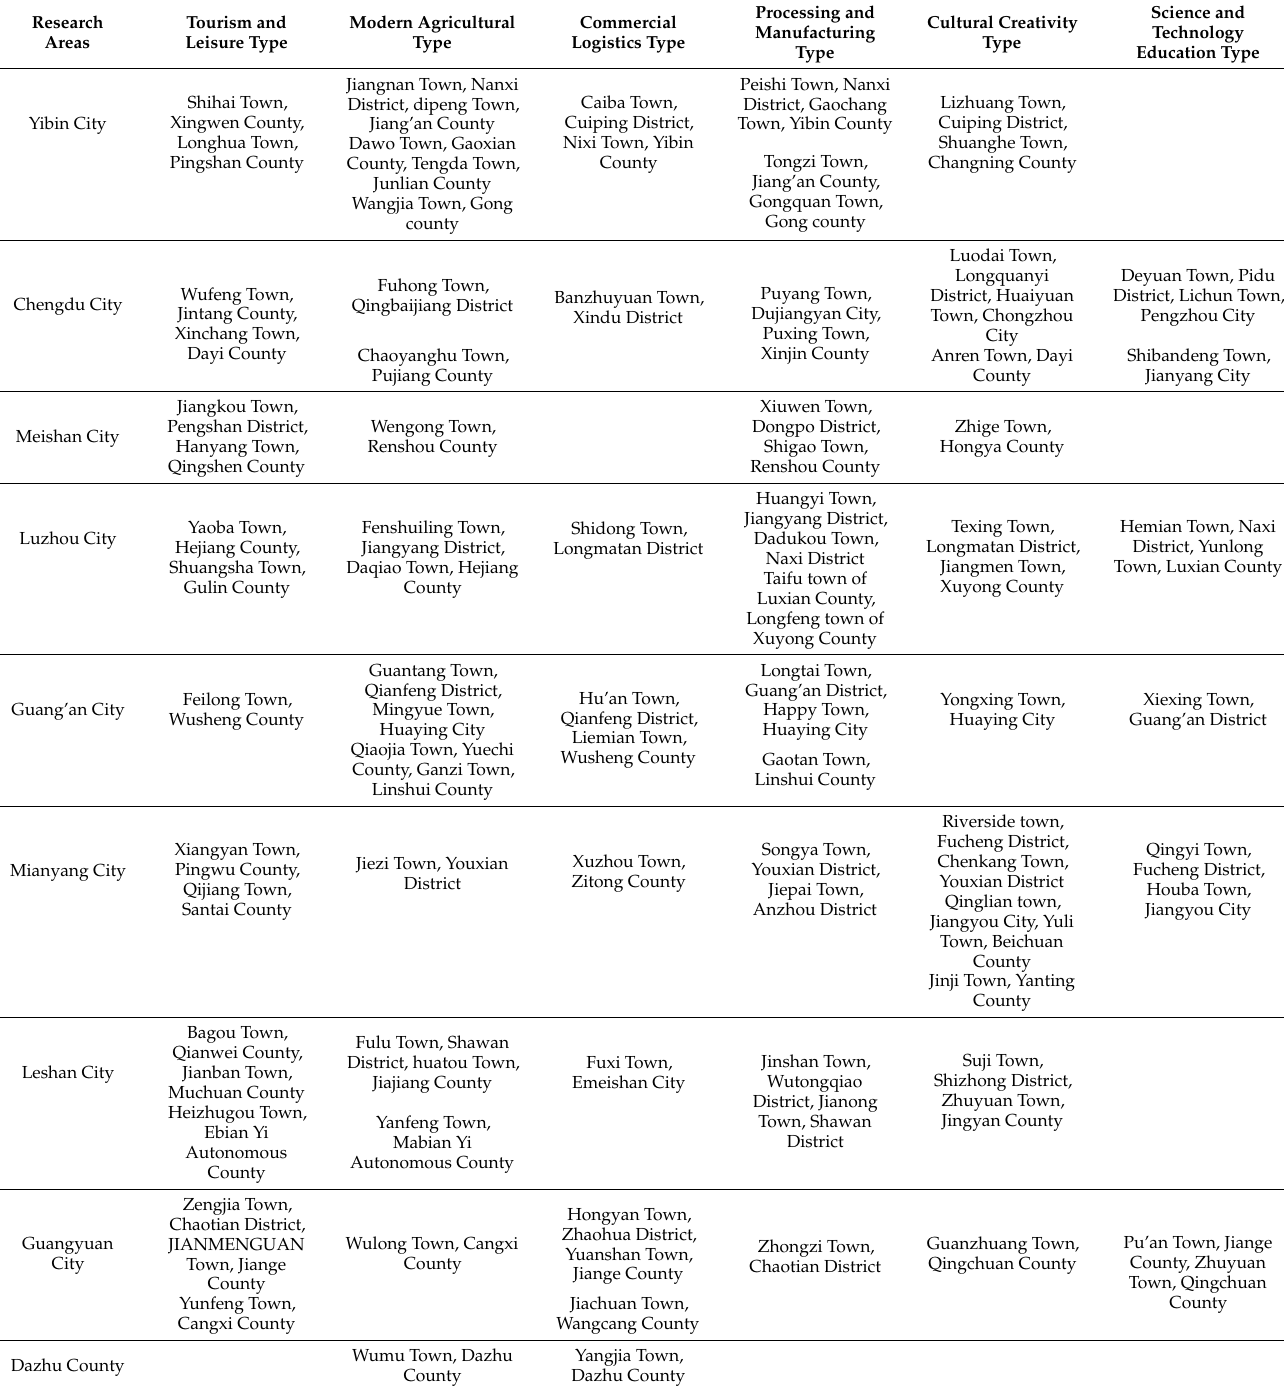
Table A1. Construction types and locations of characteristic towns in the research areas of Sichuan